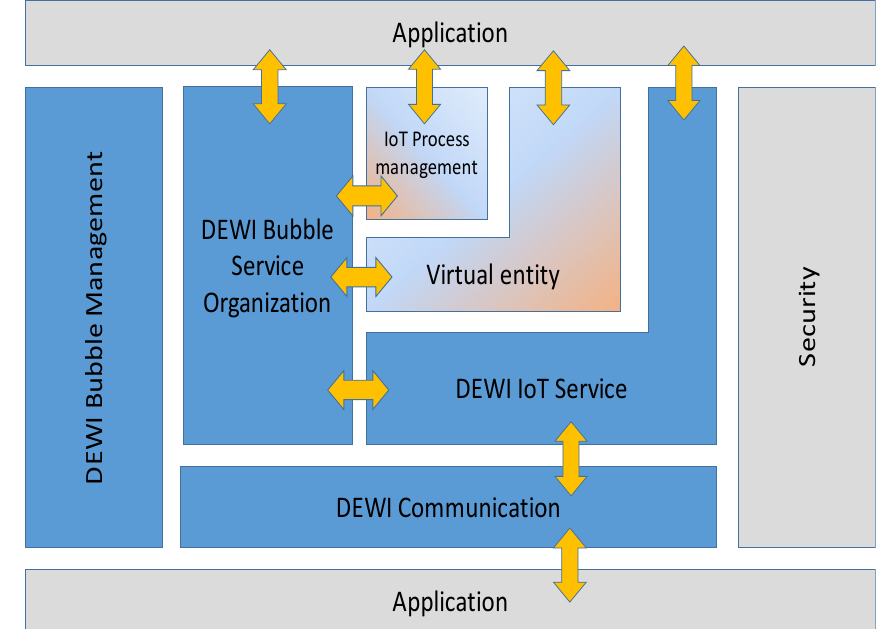
Figure 21. Mapping DEWI HLA to the IoT ARM.